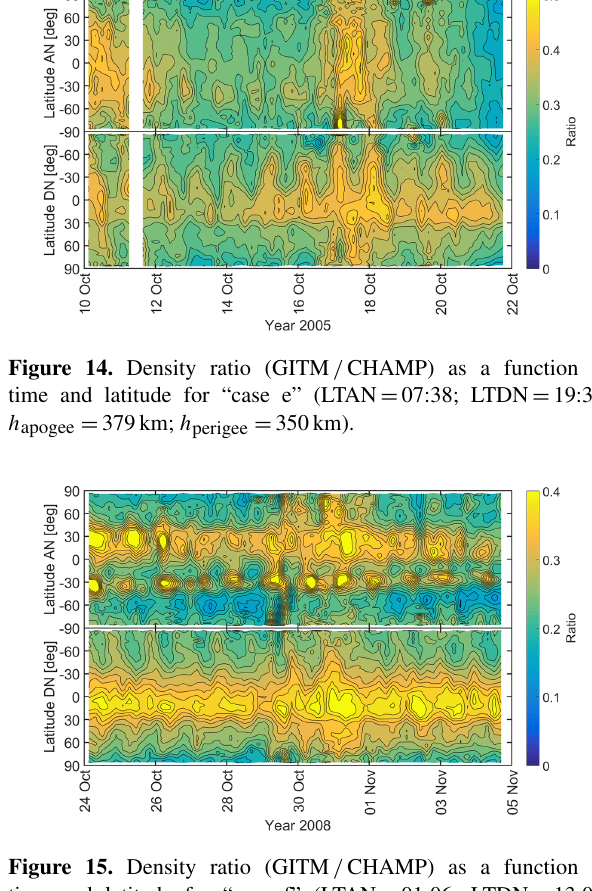
Figure 15. Density ratio (GITM / CHAMP) as a function of time and latitude for “case f” (LTAN = 01:06; LTDN = 13:06; h apogee = 353km; h perigee = 323km).